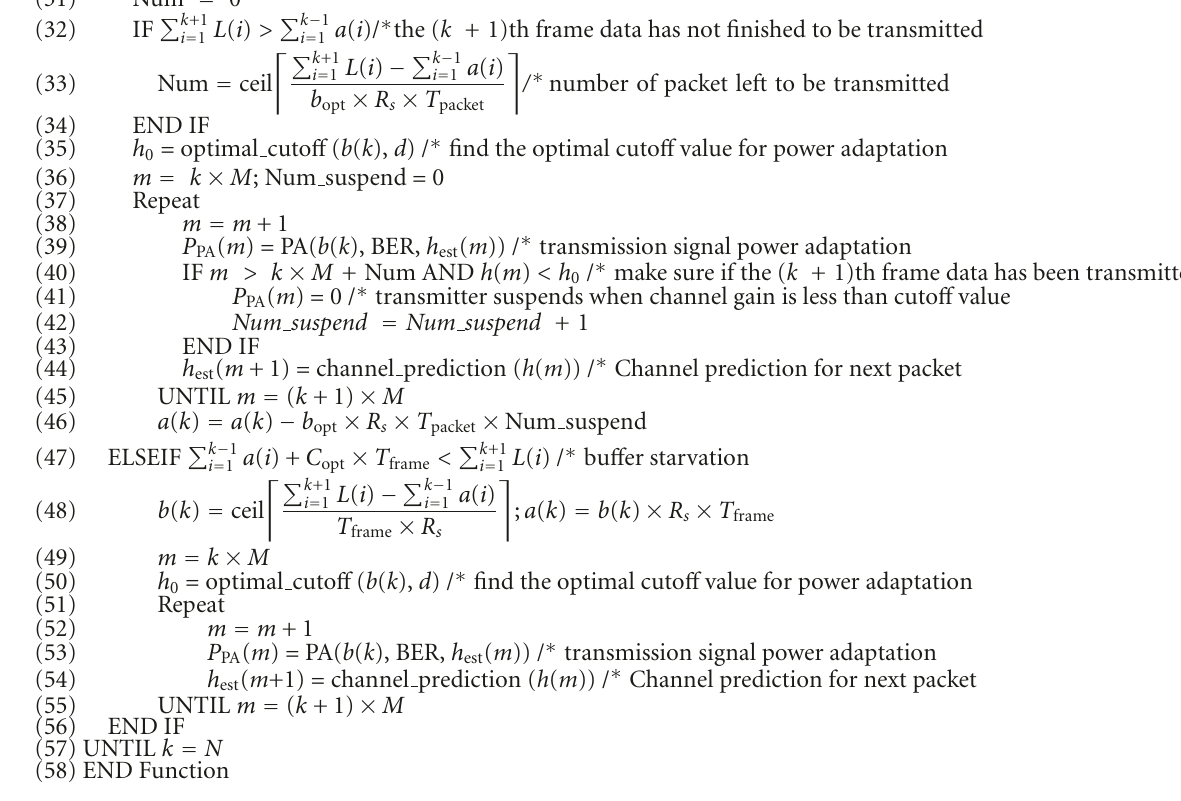
Algorithm 1: CCEVT Function: find optimal